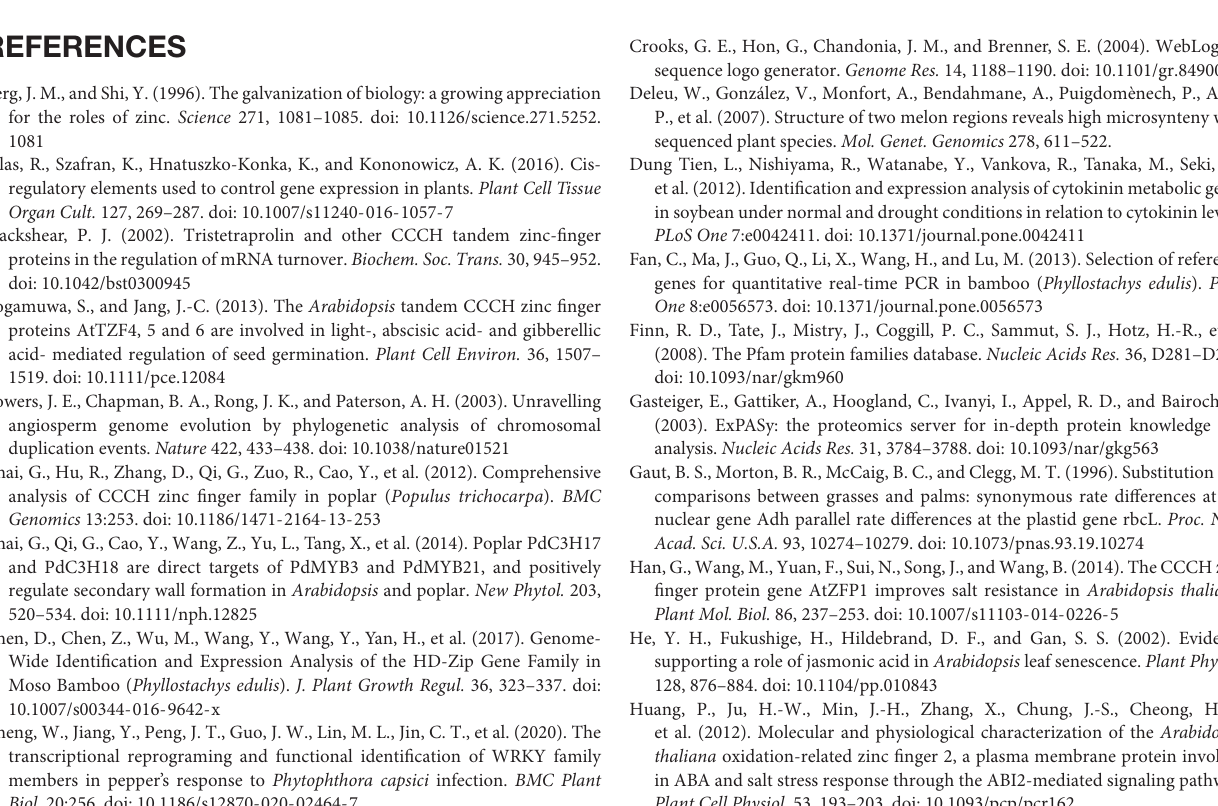
Exons, introns, and untranslated regions (UTRs) are indicated by yellow rectangles, gray lines, and blue rectangles, respectively. Supplementary Figure 4 | Synteny analysis of CCCH genes between moso bamboo and (A) dicotyledonous plant Arabidopsis thaliana , (B) maize, rice and Brachypodium distachyon . Gray lines in the background indicate the collinear blocks within moso bamboo and other plant genomes, while the red lines highlight the syntenic CCCH gene pairs. Orange or green bars represent the chromosomes. The chromosome number is labeled at the top or bottom of each chromosome. Supplementary Figure 5 | Analysis of β -glucuronidase (GUS) activity driven of PeC3H74 in overexpression Arabidopsis leaves. Supplementary Table 1 | Detailed information on conserved amino acid sequences and motif lengths. Supplementary Table 2 | K a / K s value for duplicate CCCH genes in moso bamboo.